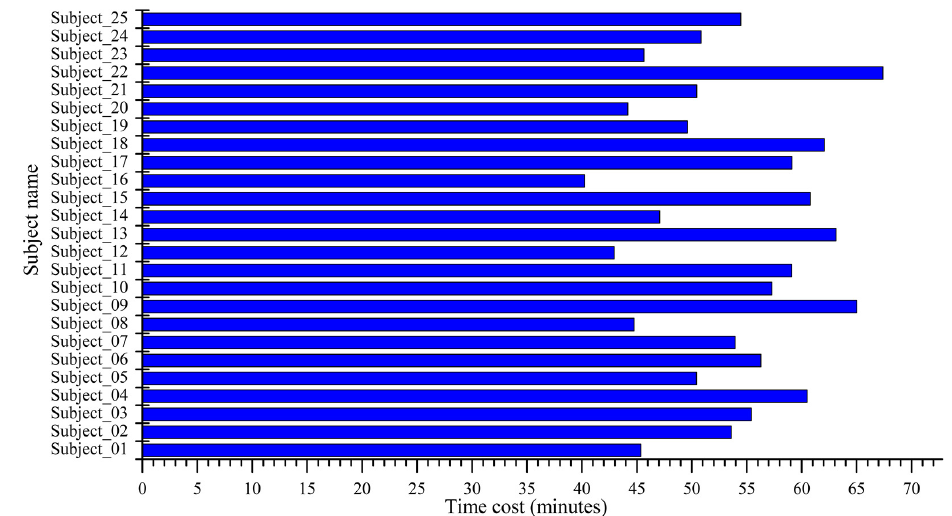
Figure 5. The time cost for each subject conducting the subjective test for the